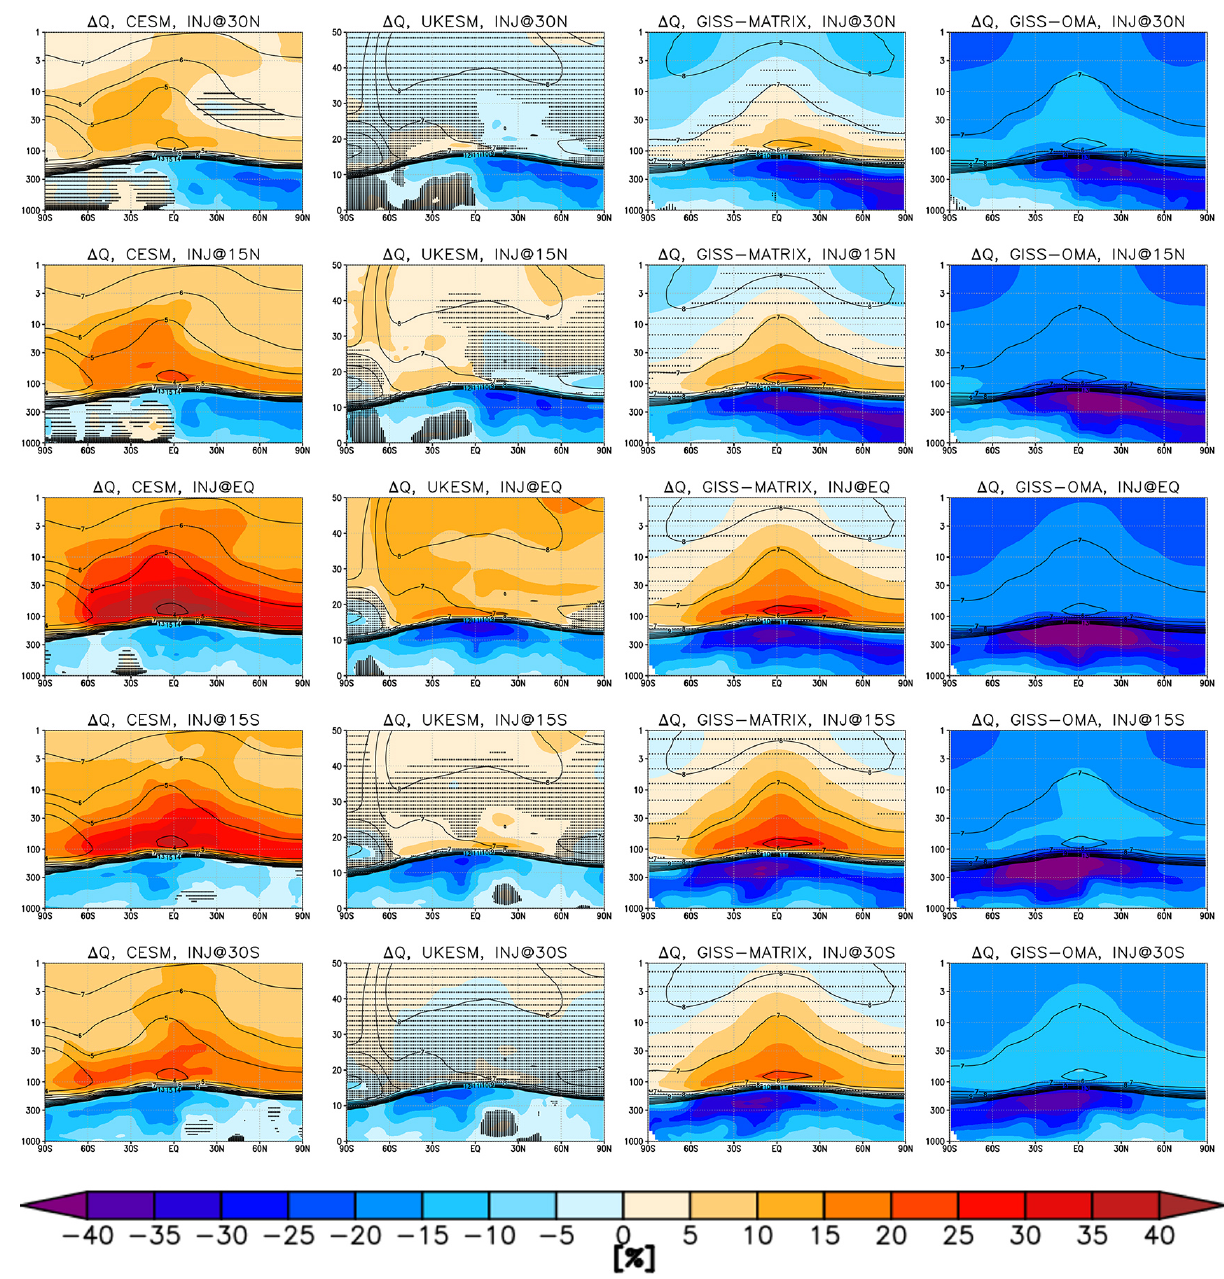
Figure 10. Yearly mean changes in specific humidity [%] averaged over the last 8 years of the simulations compared to the same period in the SSP2–4.5 run for CESM (column 1), UKESM (column 2), GISS-MATRIX (column 3), and GISS-OMA (column 4). Contours indicate the corresponding values in the SSP2–4.5 experiment in the units of parts per million by volume (ppmv) for reference. Stippling as in Fig.